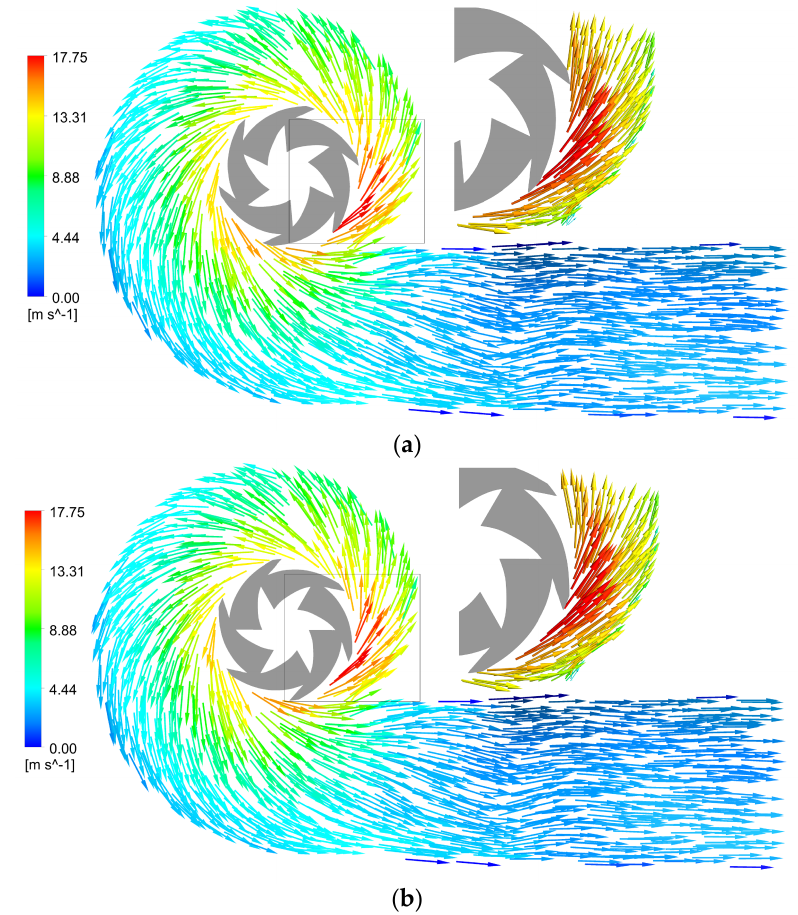
Figure 10. Velocity vector distribution at the point of 0.6 Q des with different phase positions: ( a ) 0°; ( b ) 30°.